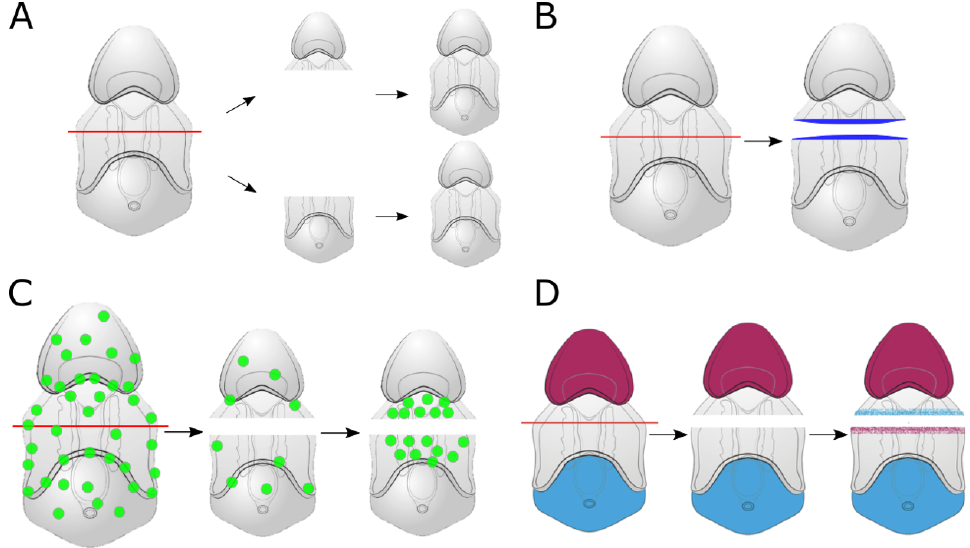
Figure 2. ( A ) graphical summary of the results from Cary et al. (2019) [41] examining mechanisms of larval sea star regeneration. Sea star larvae proportion their body size following bisection. This results in regenerated larvae that have similar proportions to that of an uncut larva but a smaller overall size. ( B ) Soon after bisection, the larval epithelium wound closes and expression of wound-induced genes is seen at the site of damage (blue area). This includes the expression of genes such as Elk and Egr and the localization of phosphorylated-ERK. ( C ) Subsequent to a reduction in overall cell proliferation early in regeneration (green circles), a cluster of proliferative cells emerges specifically at the injury site, akin to a regeneration blastema. ( D ) Loss of expression of genes along the anterior-posterior (AP) axis is recovered as regeneration proceeds. Many of these genes are components of the canonical Wnt-signaling pathway.